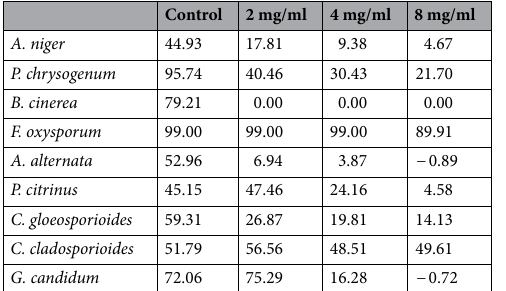
Table 4. Percentage of germinating spores after 24 h of exposure to different concentrations of PJ-WS-LE extract at 25 °C with shaking (150